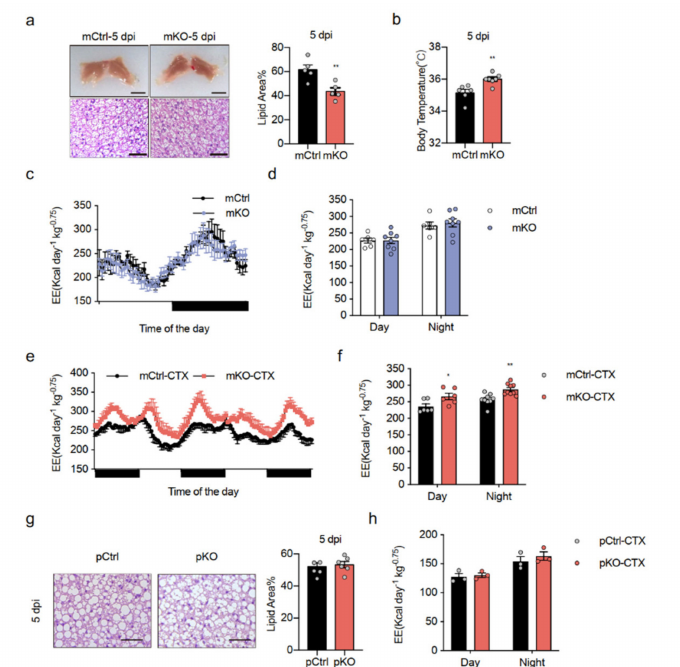
Figure 2. Mice lacking Islr in BAT exhibit increased energy expenditure: ( a ) Left: representative BAT tissues and H&E staining of BAT sections from mCtrl and mKO mice after CTX injury (n = 5); scale bar: 0.5 cm and 50 µ m; Right: quantification of H&E staining under injured conditions; ( b ) quantification of the core body temperatures of mCtrl and mKO mice after CTX injury (n = 6–7); ( c , d ) indirect calorimetric analysis of EE ( c ) and quantification of EE ( d ) of mCtrl and mKO mice under normal conditions (n = 6–8); ( e , f ) indirect calorimetric analysis of EE ( e ) and quantification of EE ( f ) of mCtrl and mKO mice after CTX injury (n = 6–9); ( g ) histological images of BAT from pCtrl and pKO mice after CTX injury; scale bar: 50 µ m; (left) quantification of H&E staining shown in the left panel (n = 6) (right), ( h ) quantification of EE of pCtrl and pKO mice after CTX injury (n = 3); mCtrl: Islr-floxed mice; mKO: BAT- and muscle-specific Islr-knockout mice, Myf5 -Cre; Islr fl/fl ; pCtrl: Islr-floxed mice; pKO: muscle-specific Islr-knockout mice, Pax7 -Cre ER ; Islr fl/fl . Error bars represent SEMs, * p < 0.05, ** p < 0.01, as determined by two-tailed Student’s t